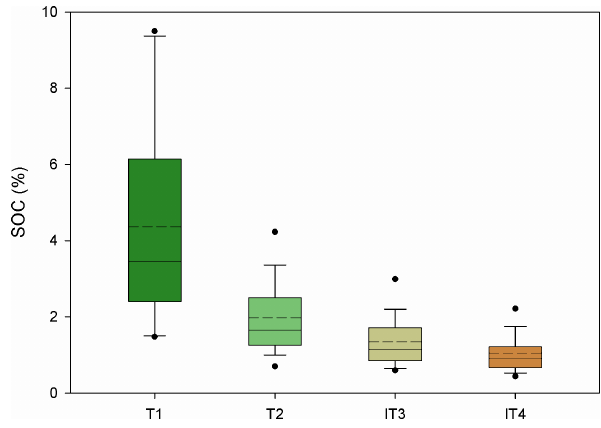
Figure 4. Box plots showing the content of soil organic carbon (SOC) for T1 (near tree trunk), T2 (near tree drip line; within tree area), IT3 (near tree drip line; outside tree area) and IT4 (intertree area between two trees) sampling locations. Median – solid line; mean – dashed line; dots – 5th and 95th percentile.